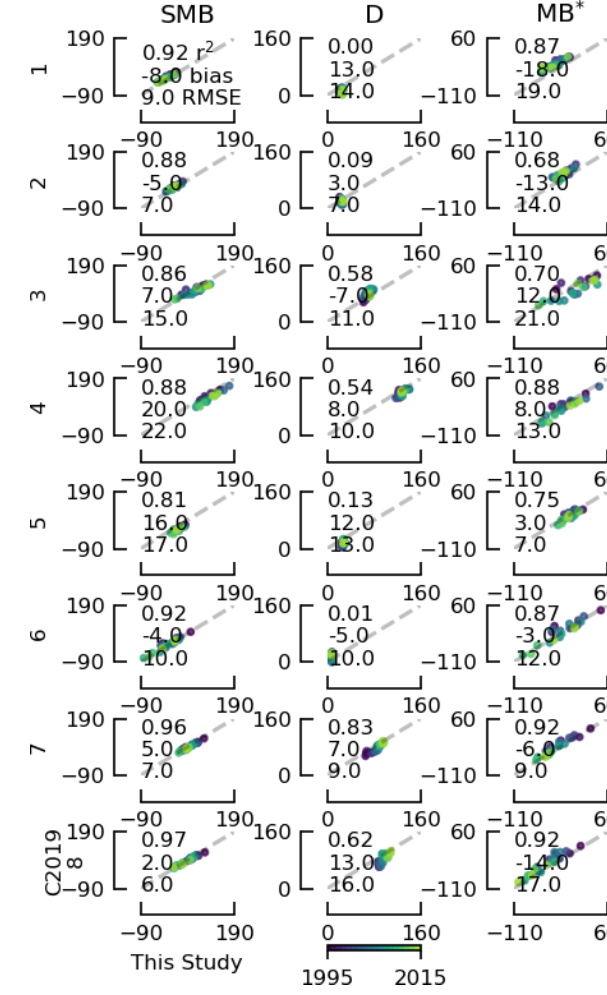
Figure C1. Comparison between This Study (excluding BMB) and Colgan et al. (2019). Same data and display as Fig. 6 except here displayed by the Zwally et al. (2012) sector. Numbers in each graph show r 2 , bias, and RMSE from top to bottom, respectively. All axis units are Gtyr − 1